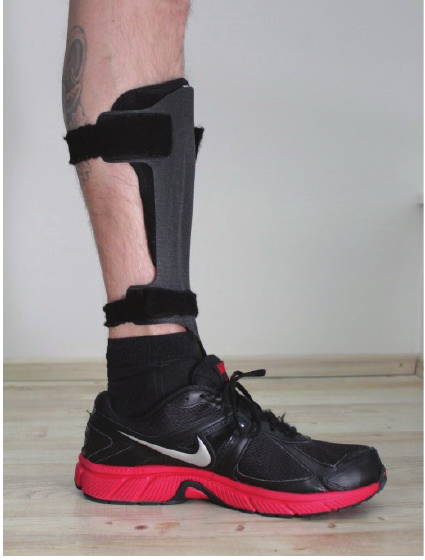
Figure 1. Kinetic return ankle foot